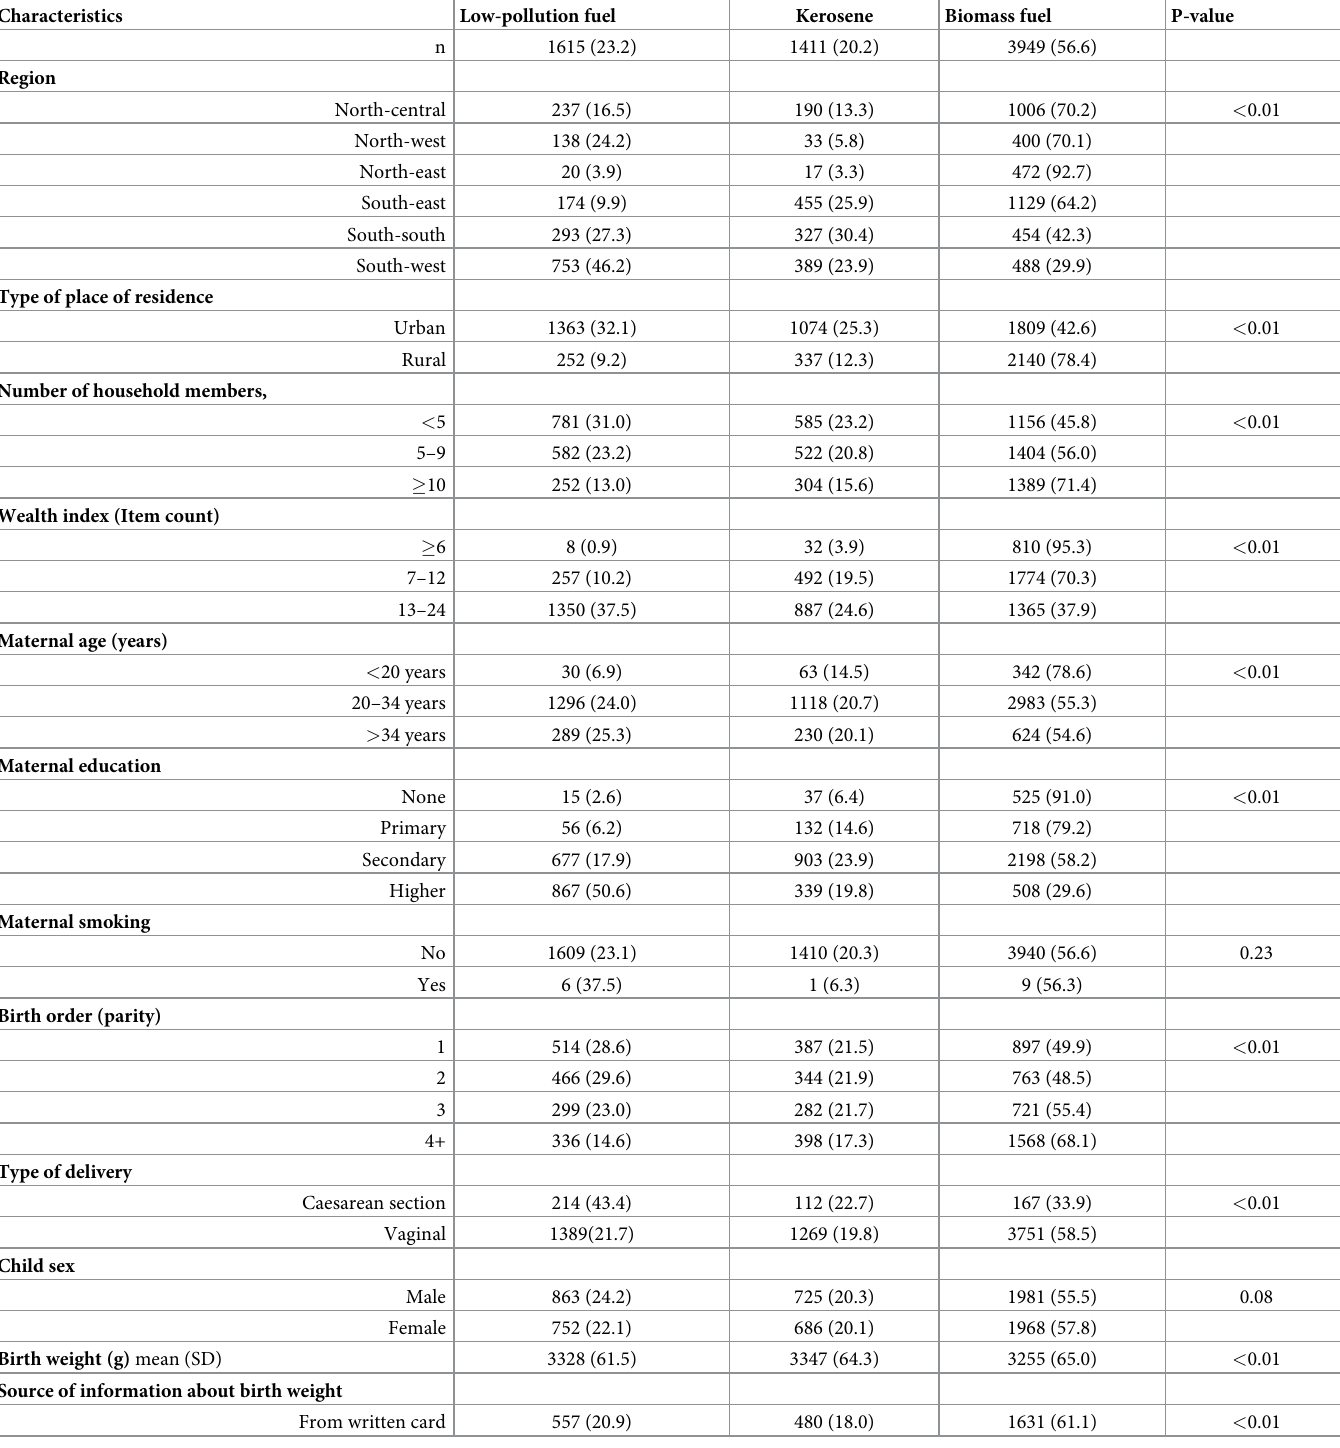
Table 4. Maternal and infant characteristics by cooking fuel type among term births, 2018 Nigeria Demographic and Health Survey (N = 6975) � .